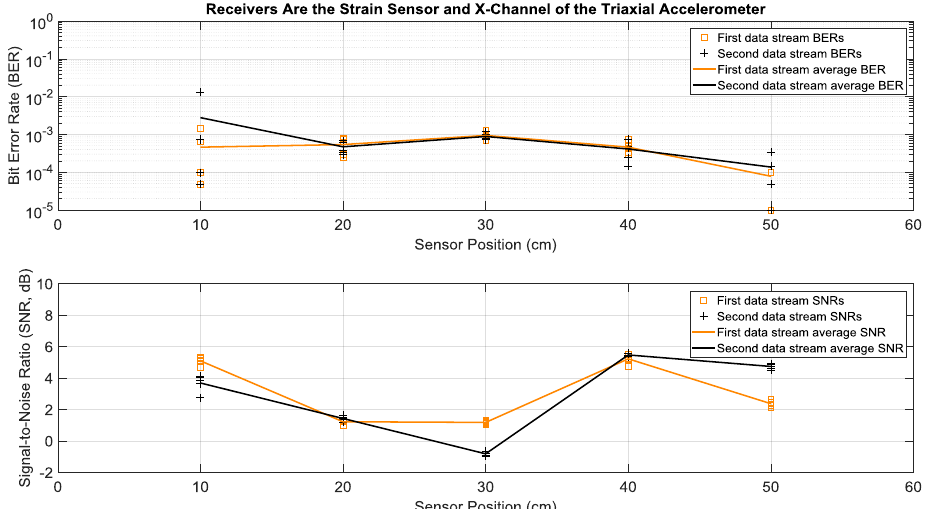
Figure 6. BERs ( top ) and SNRs ( bottom ) at different receiver positions, with two actuators transmitting two data streams simultaneously. The receivers were a strain sensor and the x -channel of a triaxial accelerometer. The piecewise linear graphs represent average BERs and SNRs for each of the two data streams versus the receiver position.